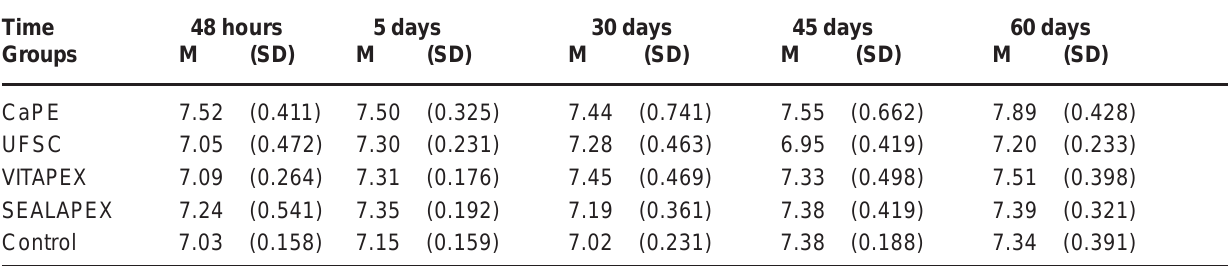
Legend: M: mean; SD: standard